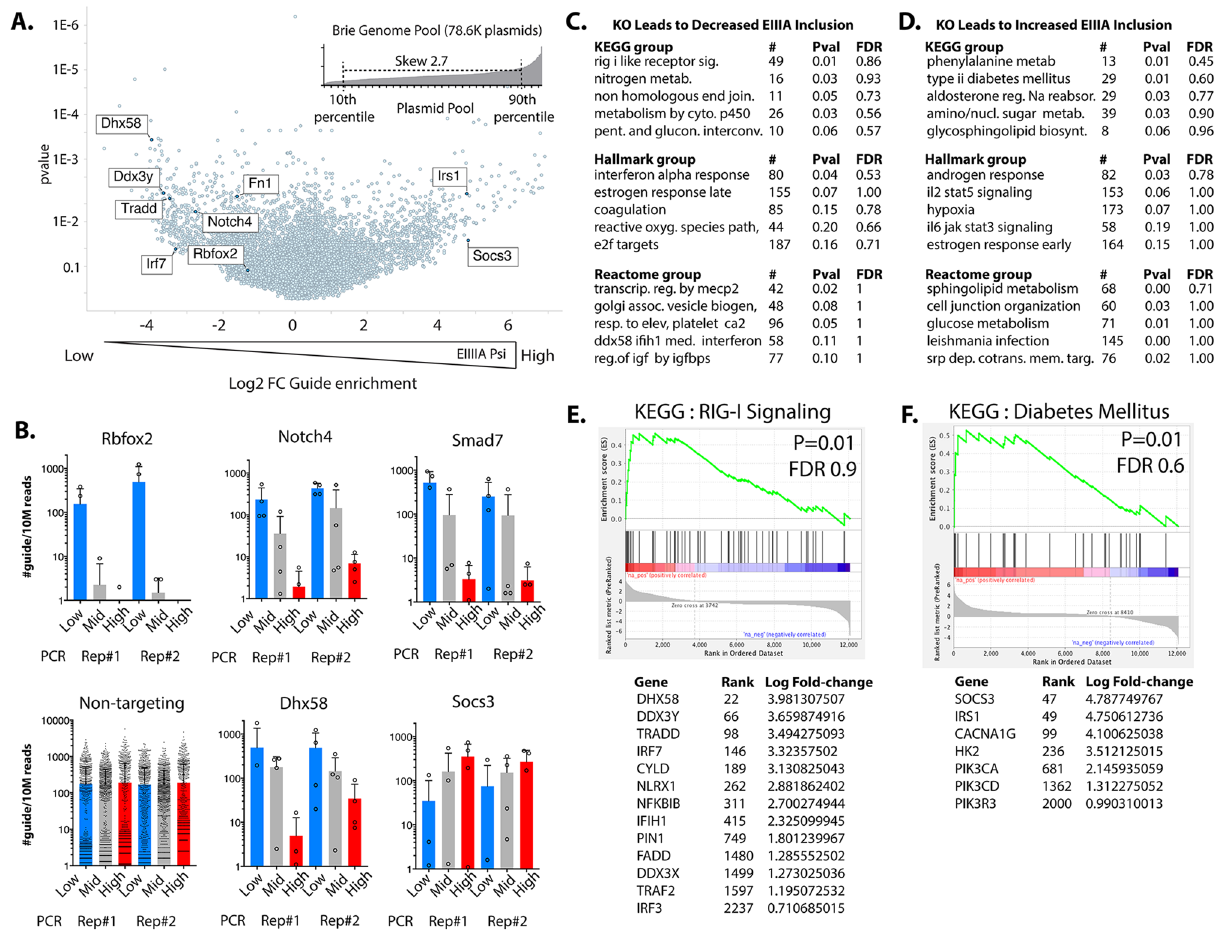
Figure 3. Genome-wide identification of EIIIA regulators. ( A ) Guide representation in plasmid pool (Brie library) after amplification in bacteria (inset), and volcano plot from MaGeCK analysis showing genes predicted to positively or negatively regulate EIIIA inclusion, based on the enrichment of their specific gRNA. ( B ) Plots showing individual guides for the genes of interest, and their relative enrichments in sorted cells with low, mid, or high levels of EIIIA inclusion. ( C ) GSEA analysis showing the enrichment of genes associated with specific KEGG, Hallmark and Reactome gene groups among those targeted in cells with reduced EIIIA inclusion (indicating that these genes promote EIIIA inclusion), and ( D ) similar analysis of genes targeted more frequently in cells with increased EIIIA inclusion (indicating that these genes suppress EIIIA inclusion). ( E ) Example of GSEA plot and enriched genes from ( C ). ( F ) Similar GSEA plot and enriched genes from ( D ). GSEA gene set enrichment, # number of genes in group. Pval unadjusted P-value, FDR false discovery